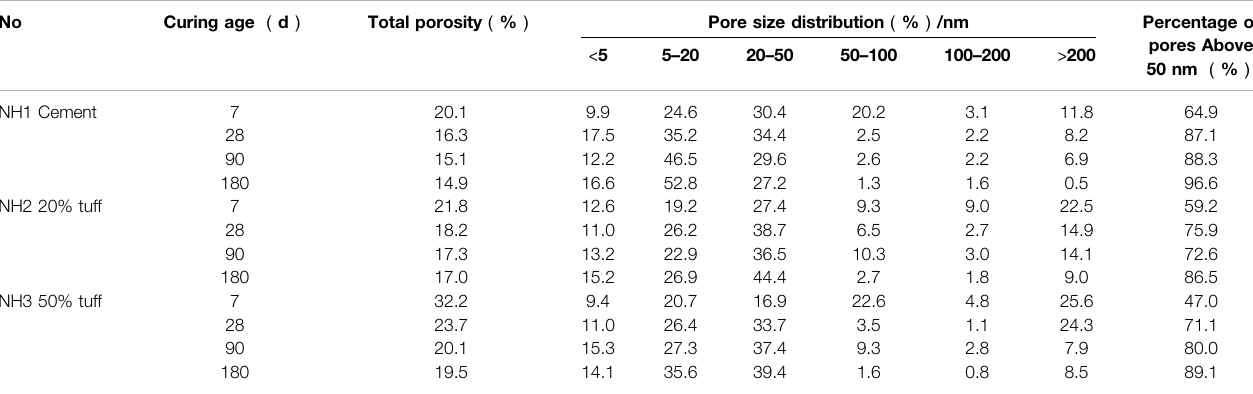
TABLE 5 | The pore structure and size distribution of the tuff powder-cement hardened paste. No Curing age （ d ） Total porosity （ % ） Pore size distribution （ % ）